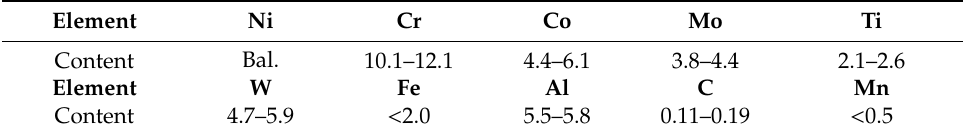
Table 1. Chemical components of K403 superalloy